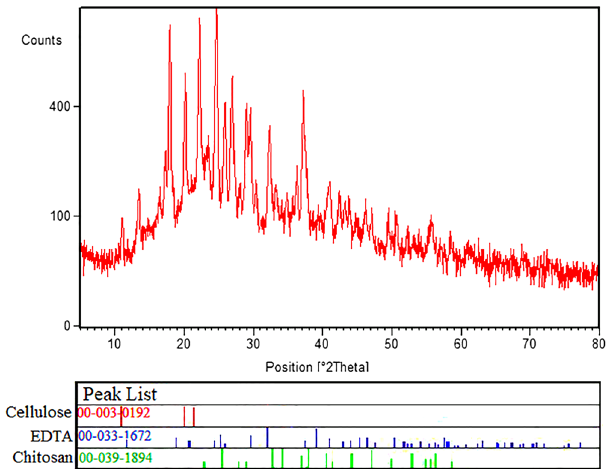
Figure 6. XRD pattern of the Cs-EDTA-Cell network ( 1 ).